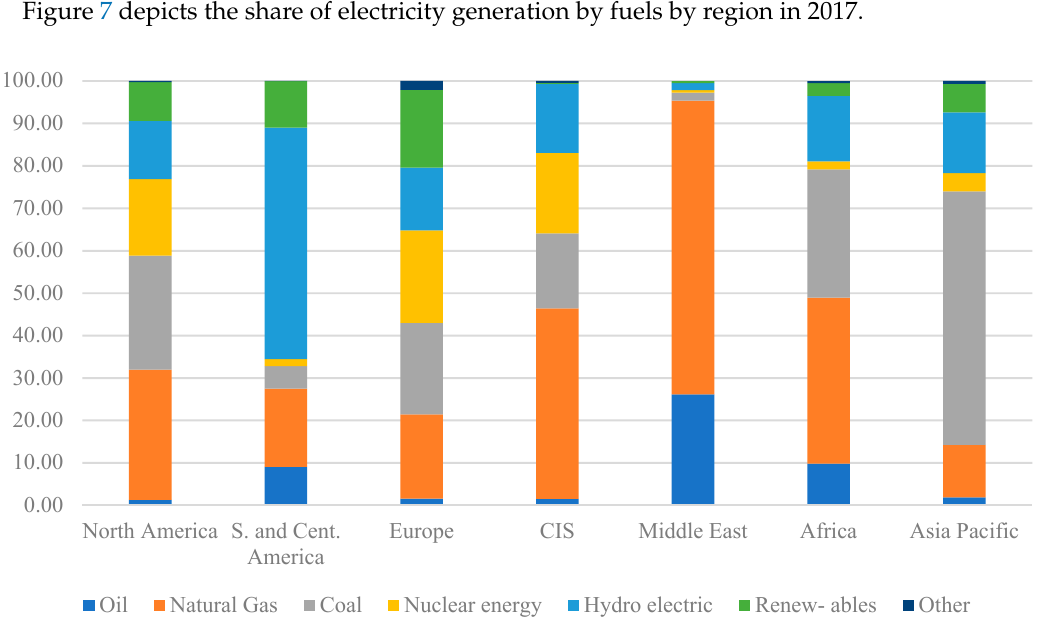
Figure 7. Regional electricity generation by fuels, 2017. CIS: Commonwealth of Independent States. Source: BP Statistical Review of World Energy (2018).